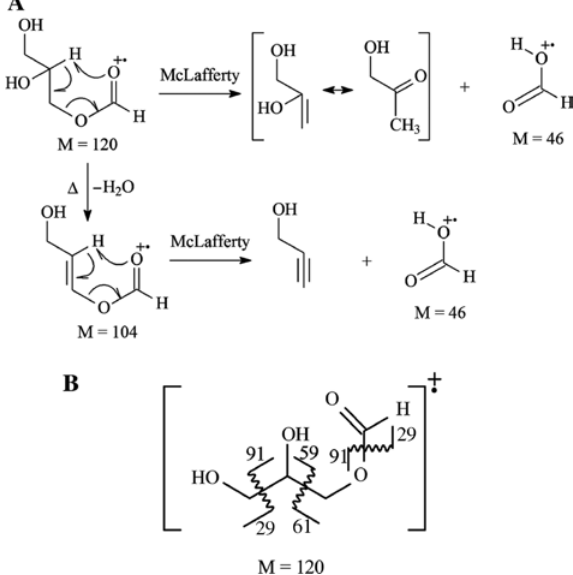
Figure 11: Two different fragmentation processes of glycerin monoformate: (A) McLafferty rearrangements at the molecule ion and its dehydration product and (B) α -scissions of the hydrocarbon skeleton in three positions.